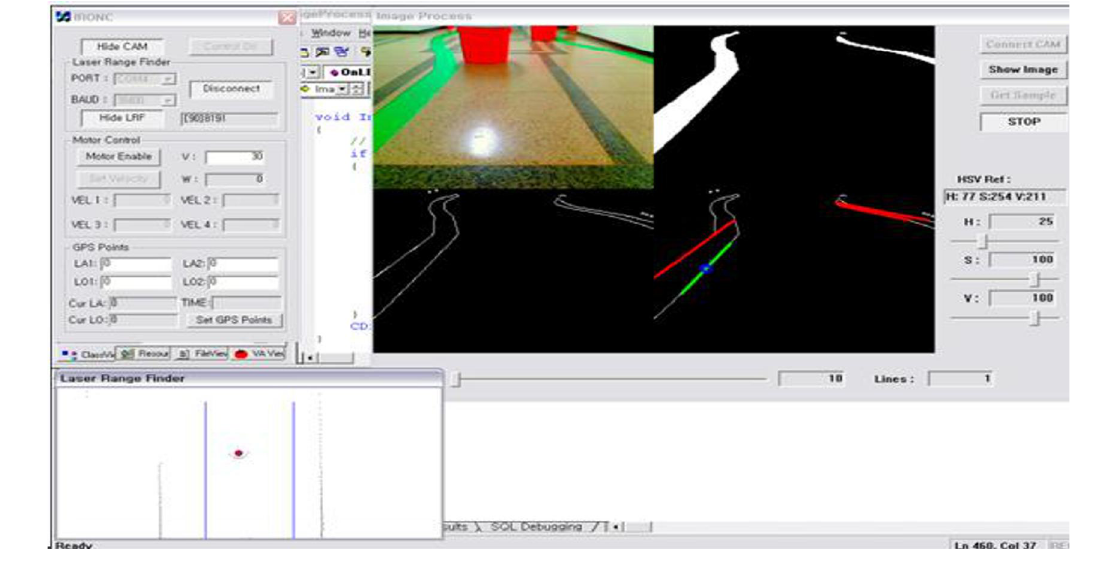
FIG. 23. COMPUTER SIMULATION WINDOW OF NAVIGATION SYSTEM IN VISUAL